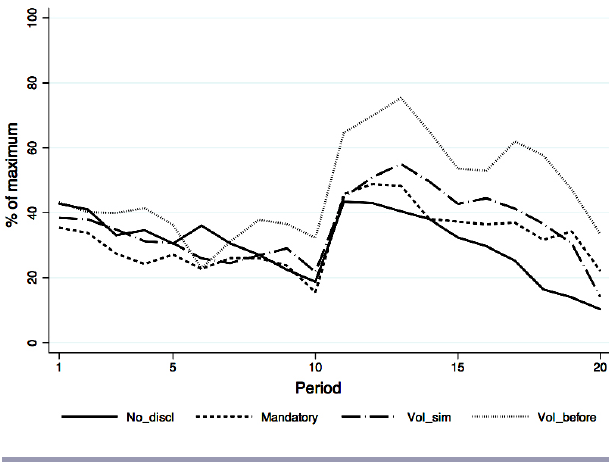
Fig. 1 . Group-level contributions (in percent) to the group fund by treatment.